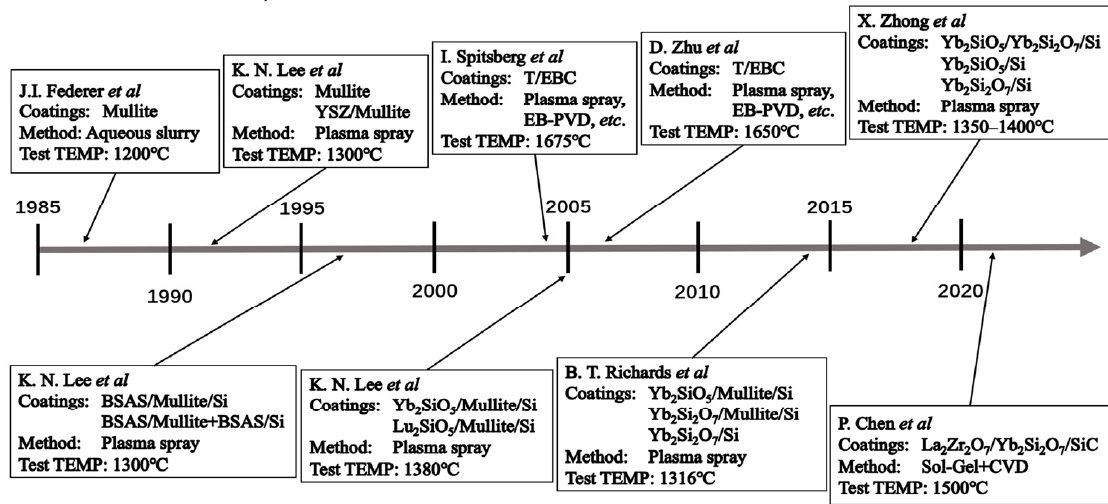
Figure 1. Development of EBCs coating systems [5–24].